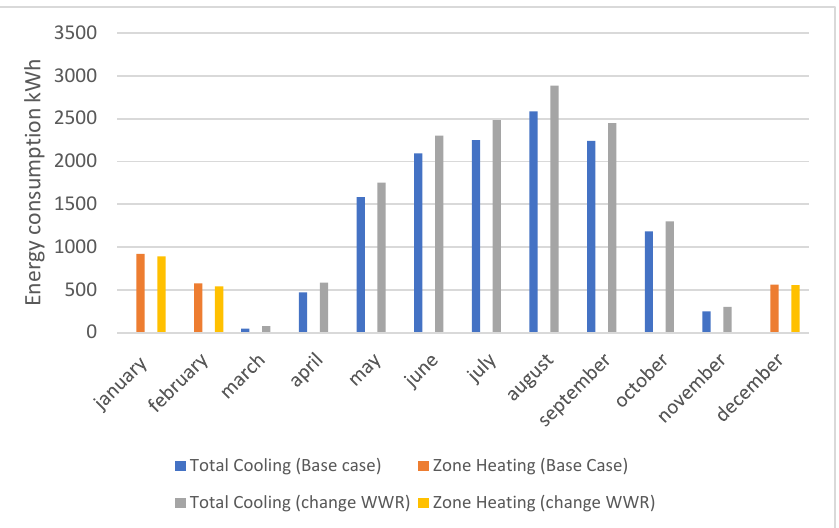
Figure 15. The annual energy consumption for Case 1 with modifying the WWR to adapt the contemporary house characteristics.